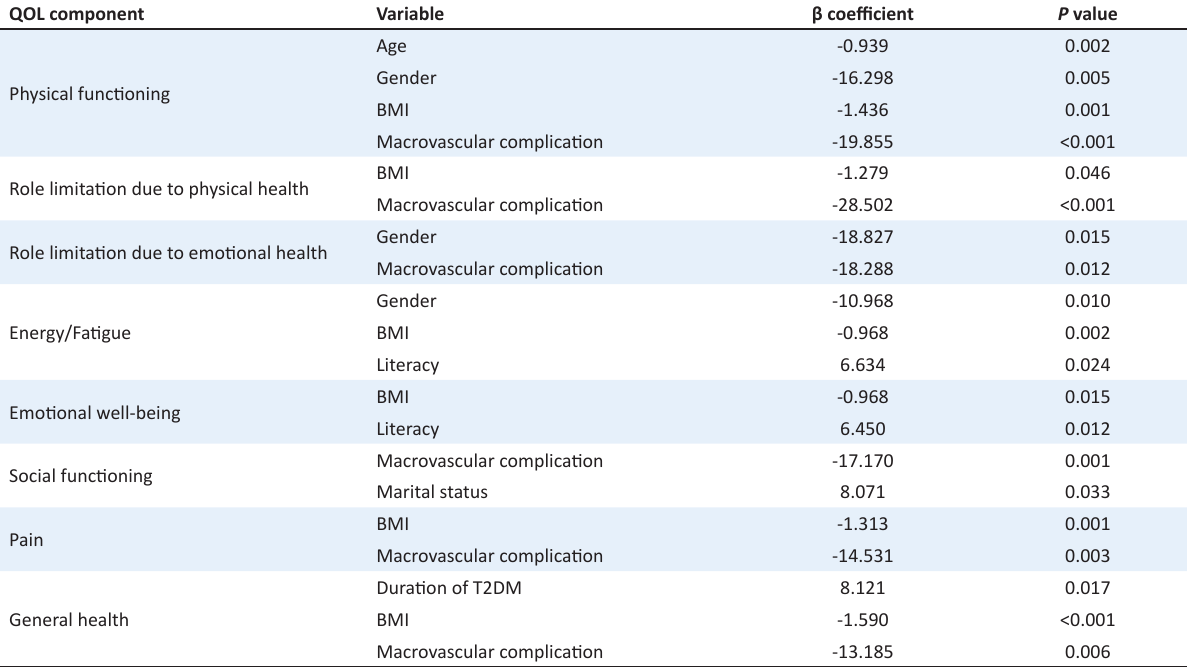
Table 3. Patient’s characteristics and SF-36 subscales (multivariate regression